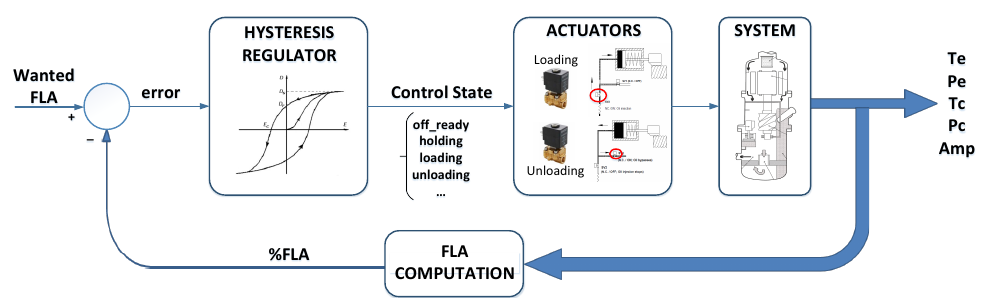
Figure 1. The continuous capacity control system in screw compressors using FLA (Full Load